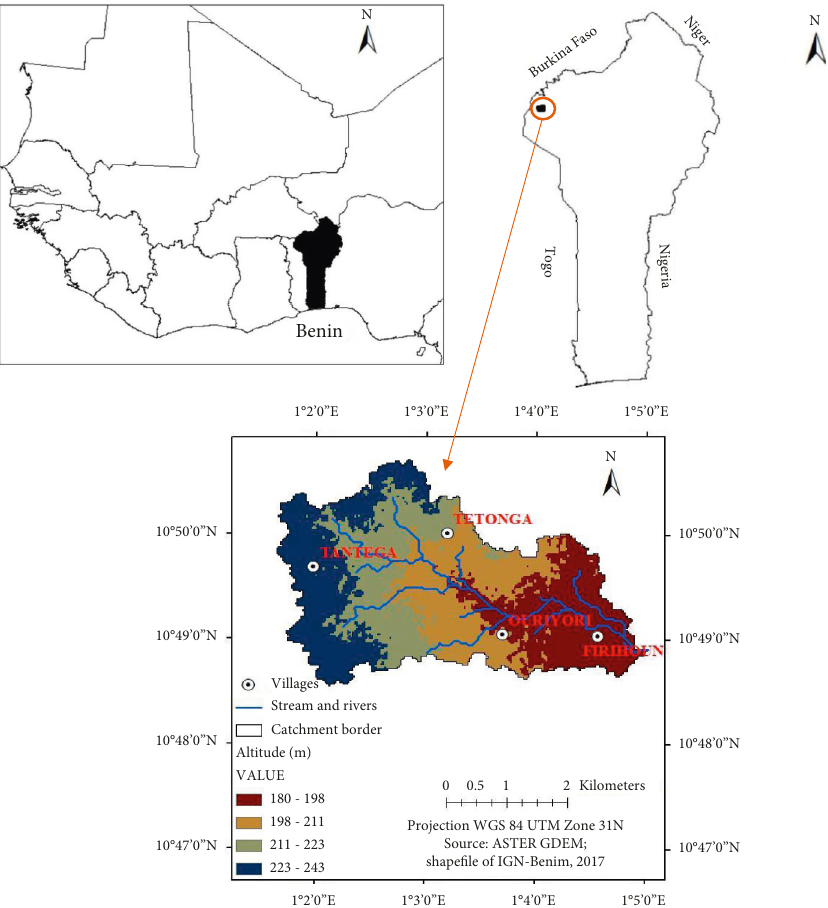
Figure 1: Location of the Ouriyori